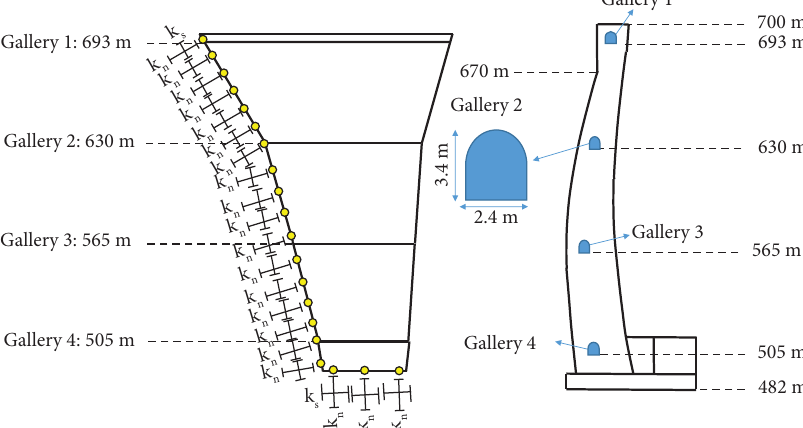
Figure 3: View of gallery spaces in the Ermenek arch dam body [33,